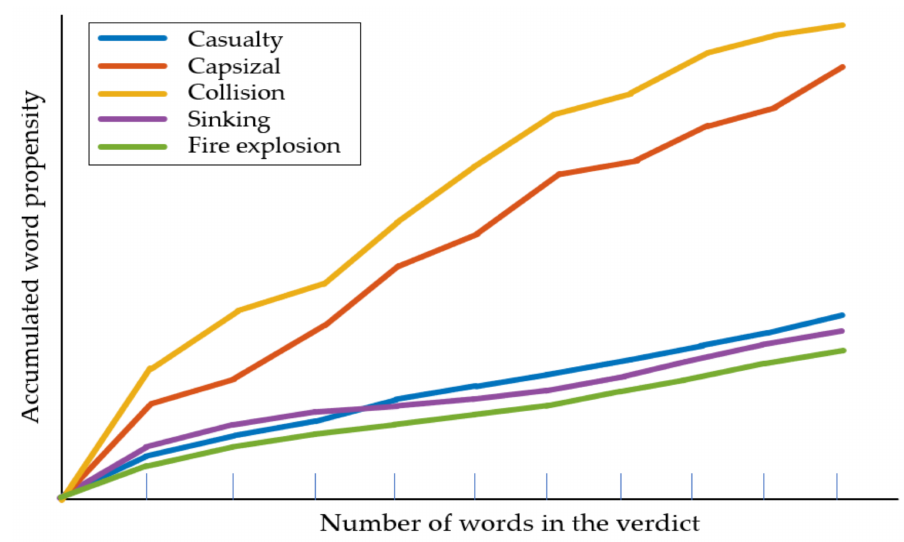
Figure 4. Example of verdict